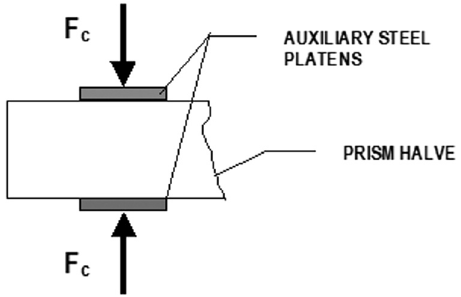
Figure 4: Scheme of compressive